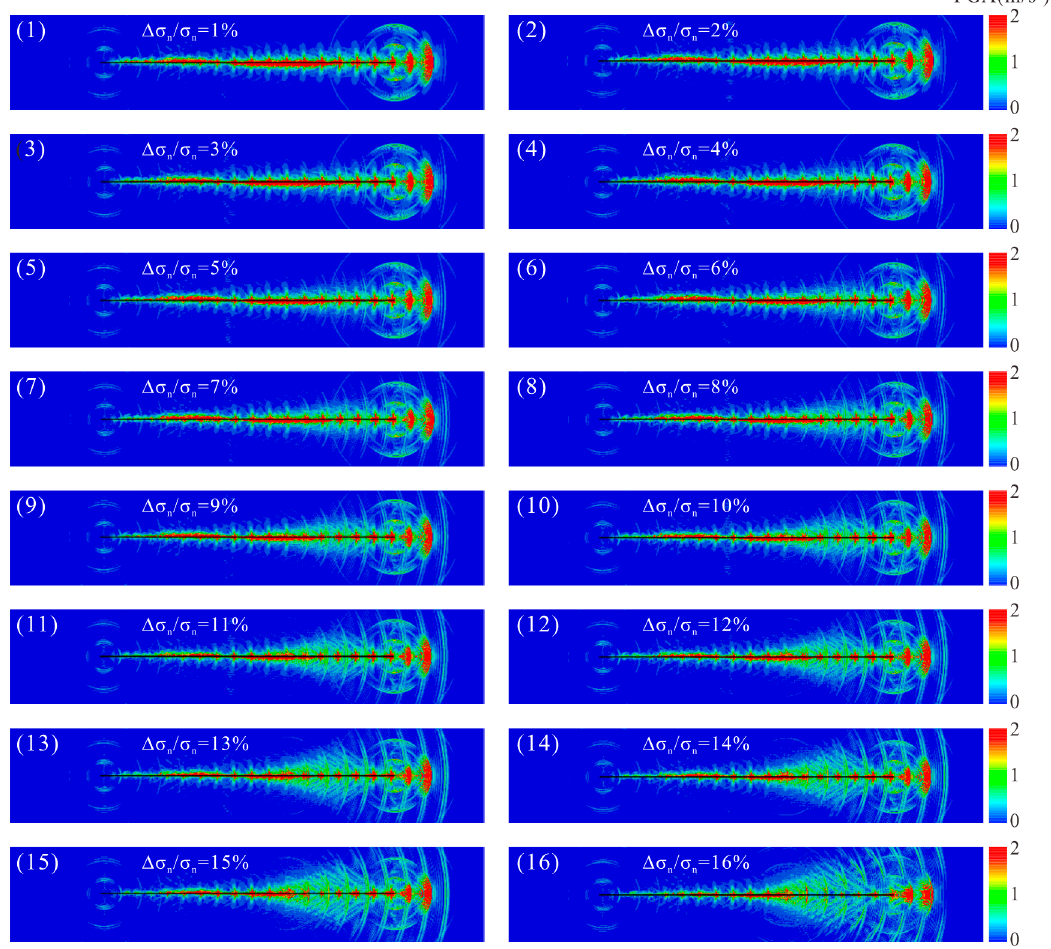
Figure 8. Distribution diagram of peak ground acceleration near faults with barriers of different Distribution diagram of peak ground acceleration near faults with barriers of strengths. di ff erent